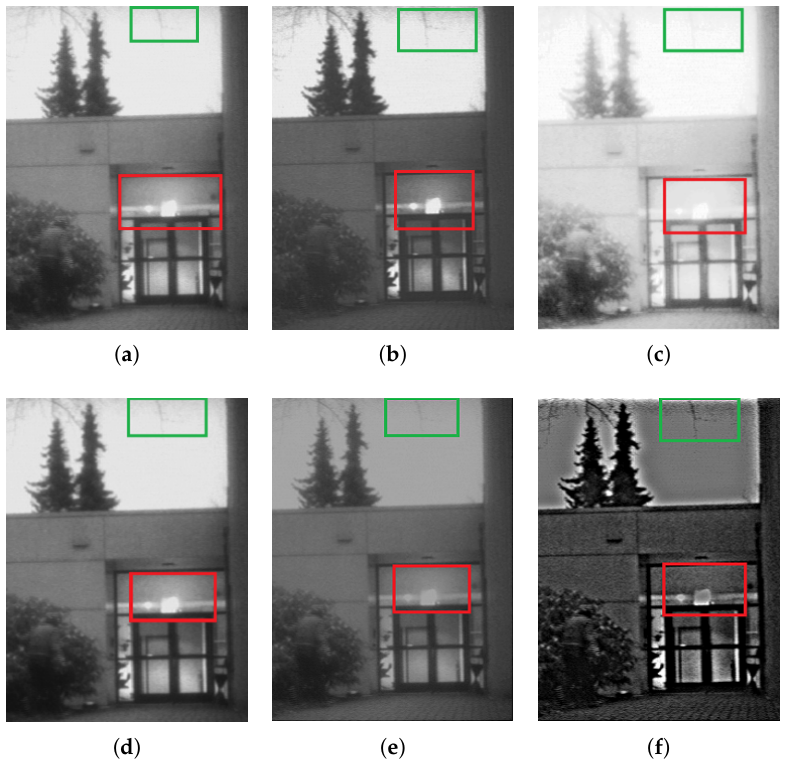
Figure 3. Image contrast enhancement algorithm, The red box and the green box are contrast areas: ( a ) Visible image; ( b ) Proposed; ( c ) HE; ( d ) Gamma correction; ( e ) LIP; ( f ) HEF. From the comparison effect of local regions, the method in this paper has a good